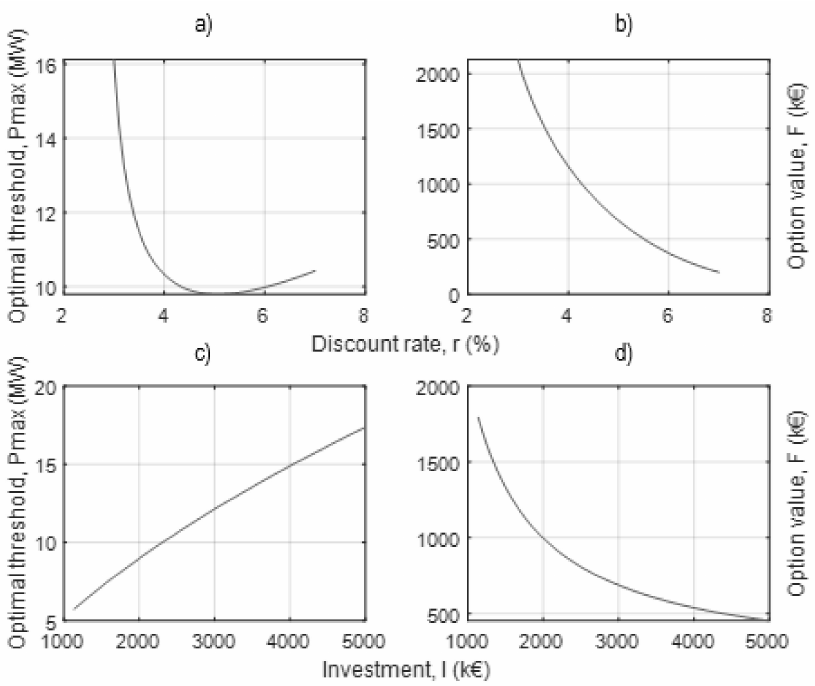
Figure 15. Sensitivity analysis discount rate ( top ) and investment ( bottom ) for optimal threshold ( a , c ) and option value ( b , d